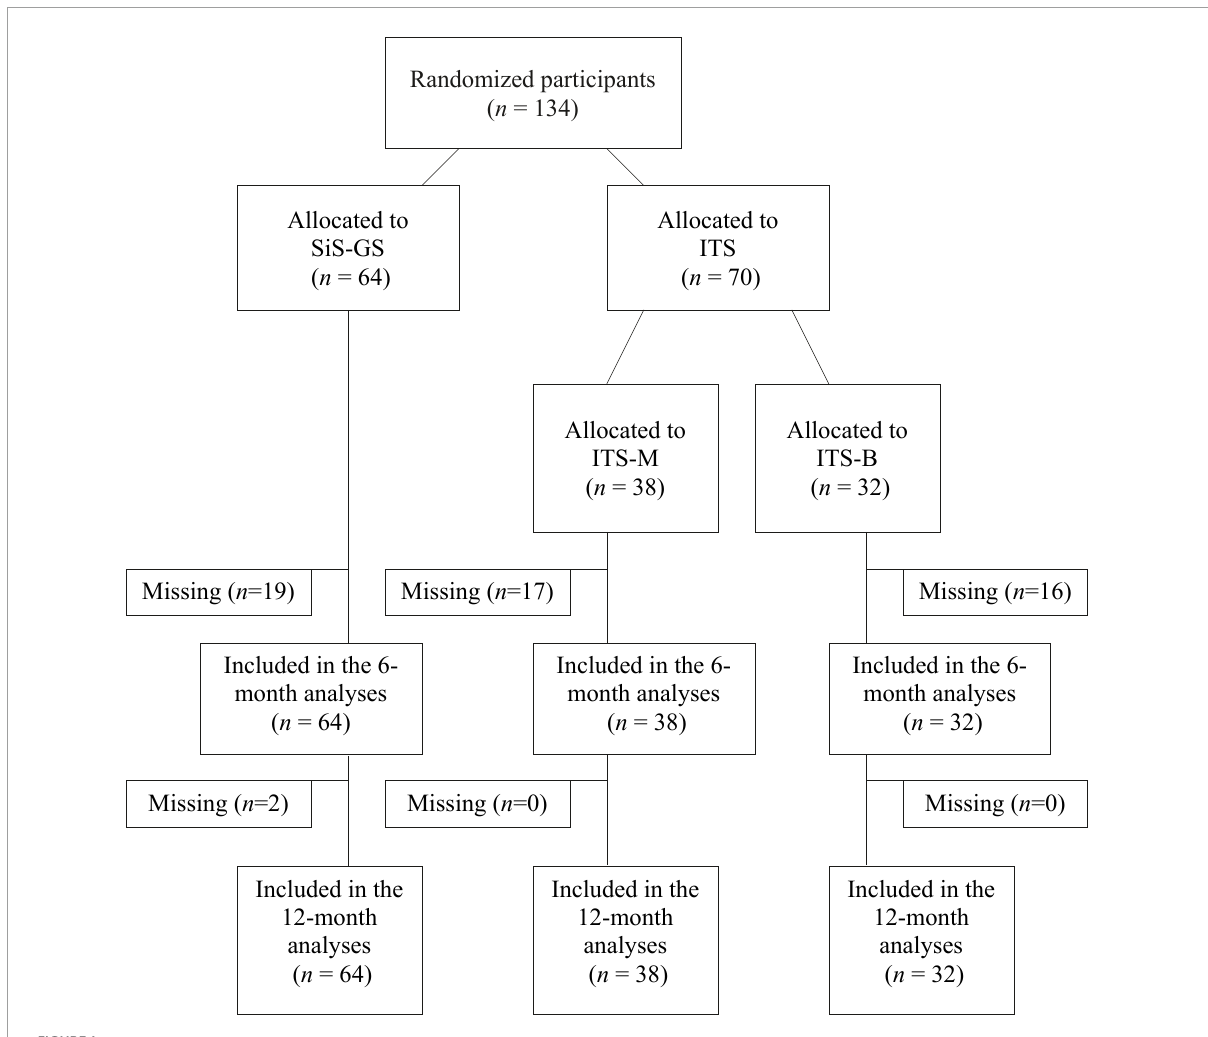
FIGURE1 Flow diagram. SiS, The Swedish National Board of Institutional Care; SiS-GS, SiS group supervision; ITS, individual telephone supervision; ITS-B, individual telephone supervision including systematic feedback based on only the behavior counts part of the objective protocol; ITS-M, individual telephone supervision including systematic feedback based on the entire objective